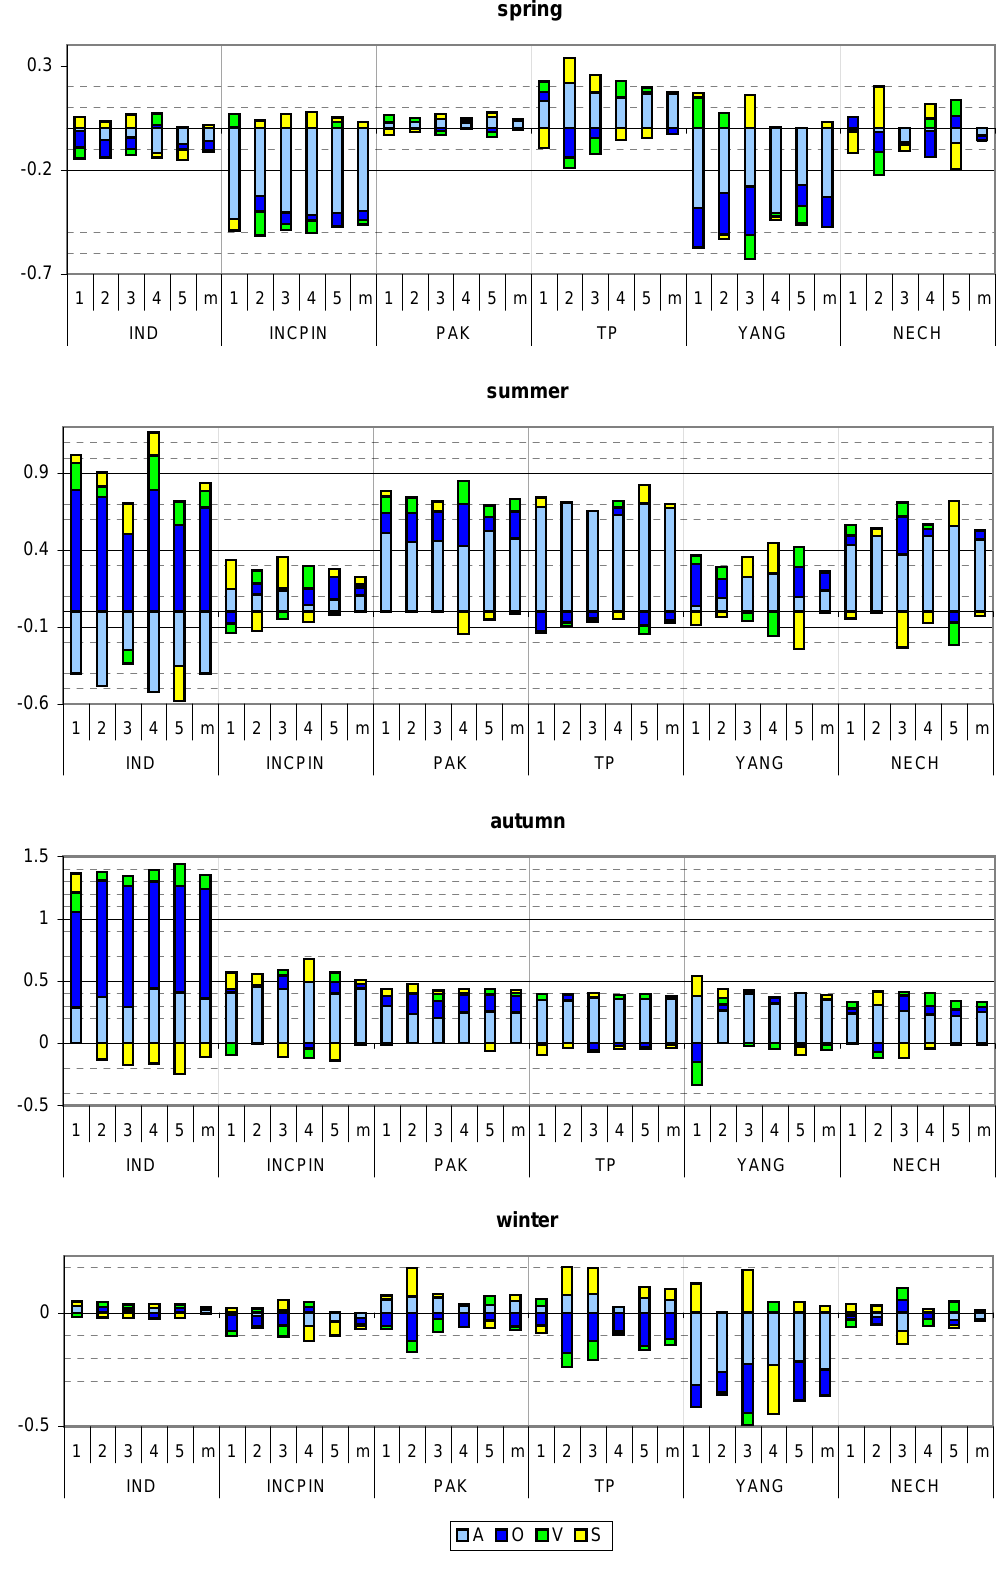
Fig. A2. Same as A1, but for precipitation [mm/day]. Please note the different scales.